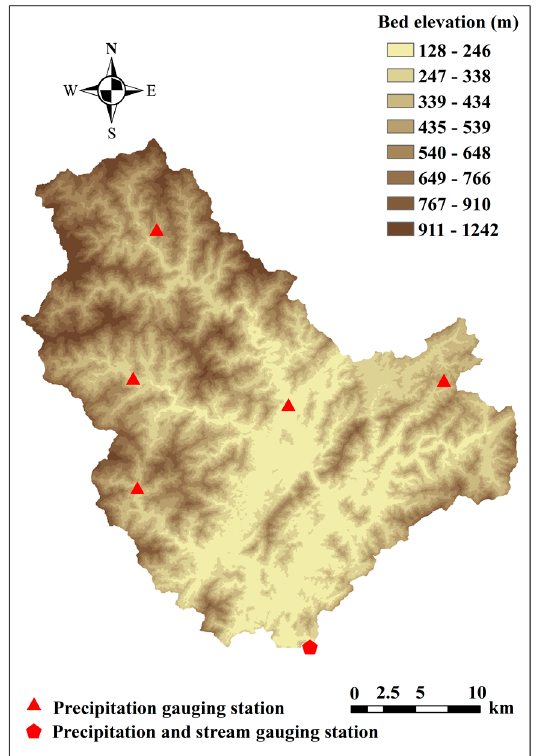
Figure 1. Map of Misai basin.